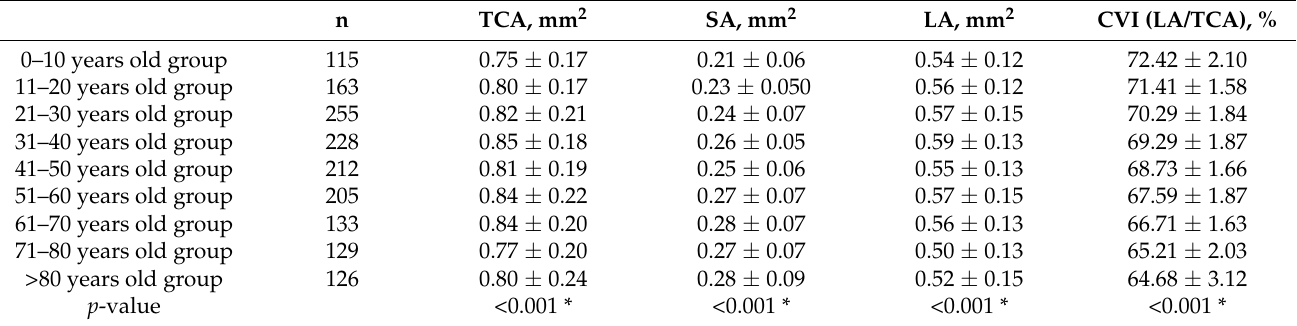
Table 2. Comparison of TCA, SA, LA, and CVI in various age groups.